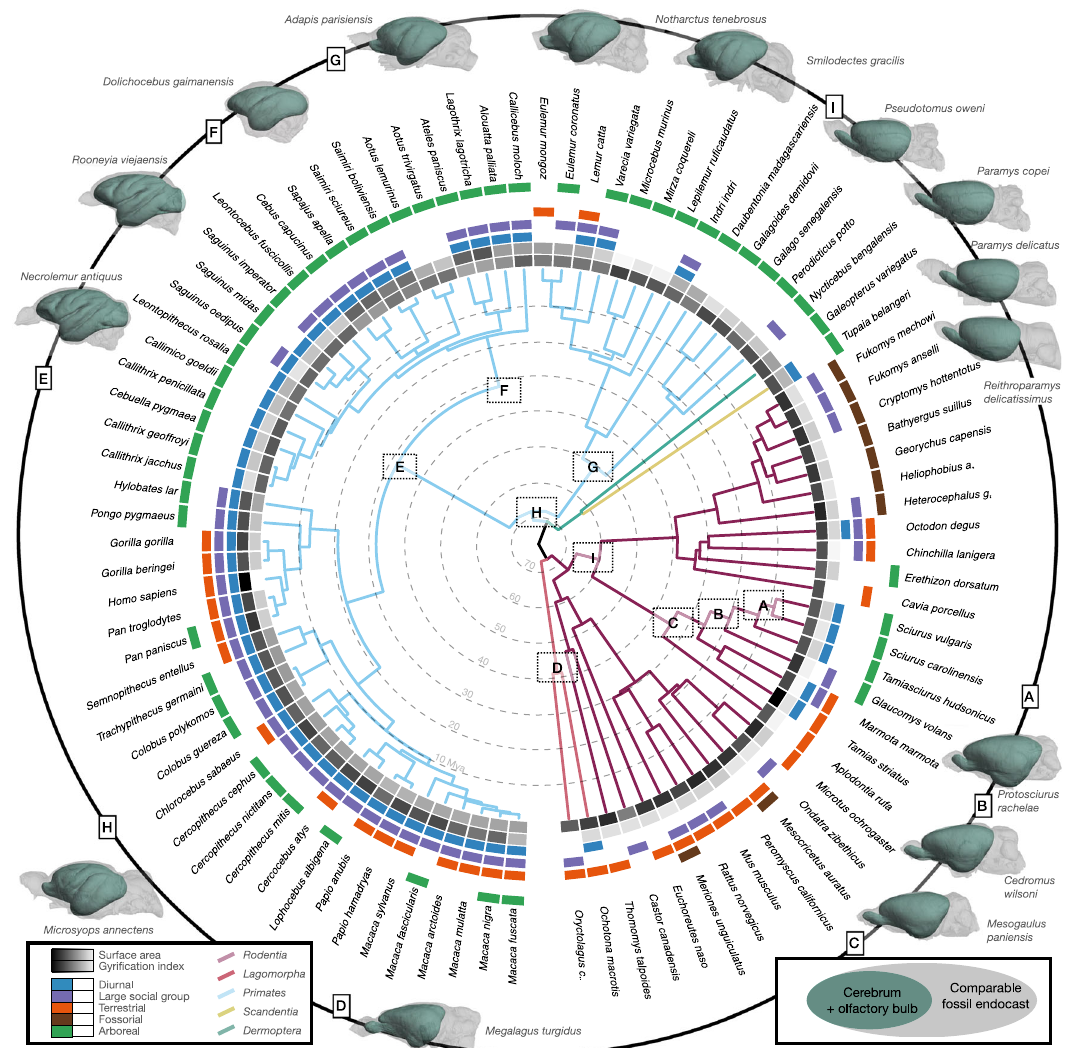
Fig. 1 | Phylogenetic tree of the dataset used in this study. The dataset covers 90species(58primates,28rodents,2lagomorphs,1scandentia,1dermoptera),for which 5 binary ecological and behavioural categorical indicator variables were collected (Large group size, diurnality, arboreality, terrestriality and fossoriality, see Supplementary Datas 1a, 2a and 2b). Estimates of the morphology of potential ancestralshapeswerecomputedafteriterativepairwisealignmentofsisterspecies.